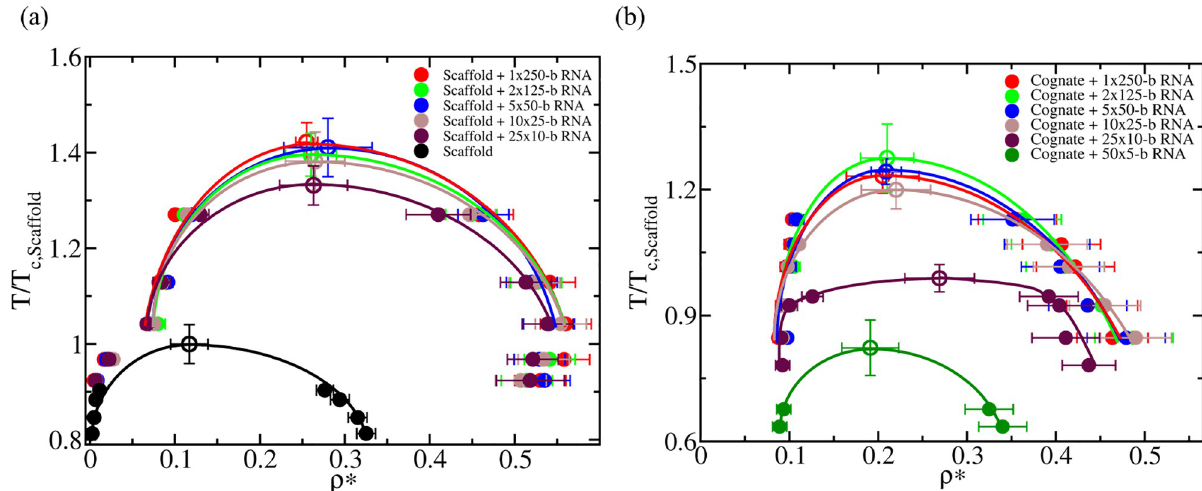
Fig 5. (a) Phase diagram in the temperature–density plane for a scaffold protein that, like FUS, can phase separate via homotypic protein interactions (black curve), and for mixtures of a fixed RNA/protein concentration using different RNA strand lengths as indicated in the legend. (b) Phase diagram in the temperature-density plane for a cognate protein that, like PR 25 , does not exhibit LLPS on its own, and that only undergoes LLPS upon addition of RNA. The RNA concentration in both panels was kept constant in all simulations at a 0.25 nucleotide/protein ratio. Filled circles represent the coexisting densities evaluated from DC simulations, while empty circles depict the critical temperatures estimated from the law of rectilinear diameters and critical exponents near the critical temperature [119]. The error bars in the coexistence densities represent the standard deviation, while those of the critical points represent the extrapolated uncertainty when applying the law of rectilinear diameters and critical exponents. Temperature in both panels has been normalized by the critical temperature of the pure scaffold system, T � ¼ 0 : 09 in reduced units (empty black circle in (a)). c ; Scaffold